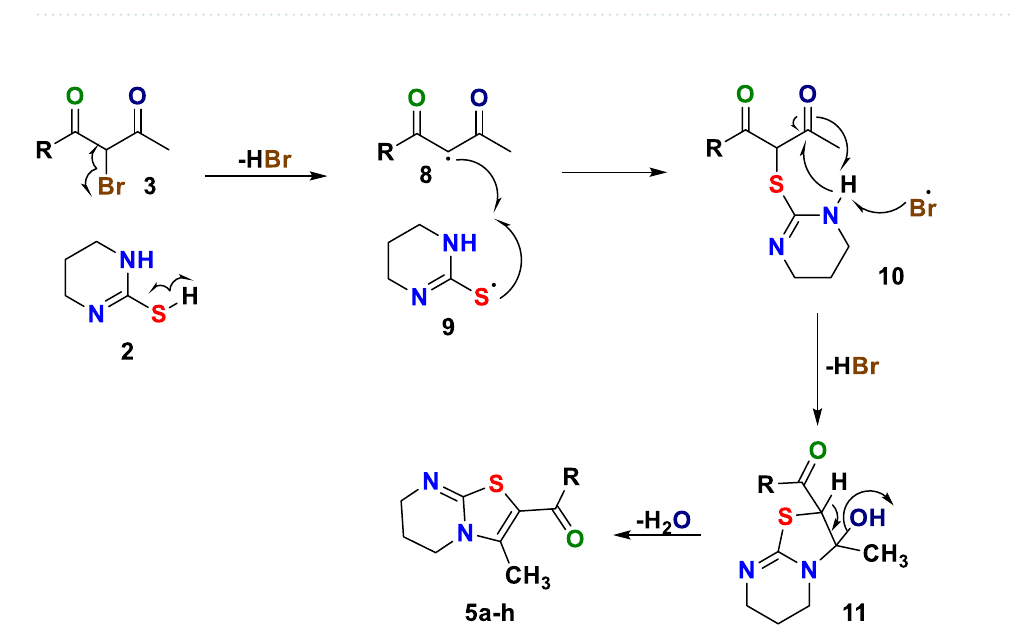
Figure 4. Showing a proposed mechanism for the synthesis of thiazolo[3,2- a ]pyrimidines 4a–h .